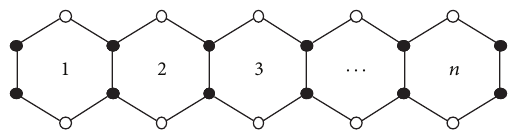
Figure 1: The linear hexagonal chain with 𝑛 hexagons 𝐿 𝑛 .